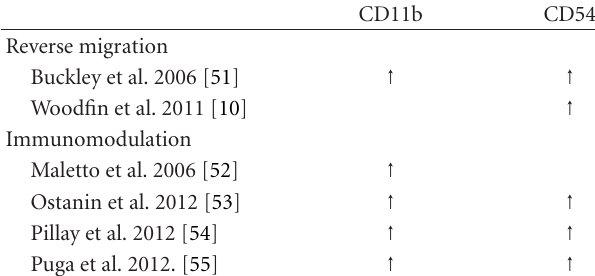
Table 1: Comparison of surface phenotypes between studies of neutrophil reverse migration and immunomodulation by neu- trophils. CD11b (integrin α M ), which is a component of Mac-1 integrin, and CD54 (ICAM-1) were the surface molecules with the most overlap between these studies. Blank spaces indicate that the expression of this molecule was not addressed by a particular study. The ( ↑ ) indicates that expression of the indicated molecule was elevated over the appropriate control sample of neutrophils (non reverse migrated, not responsible for neutrophil e ff ects on lymphocytes,